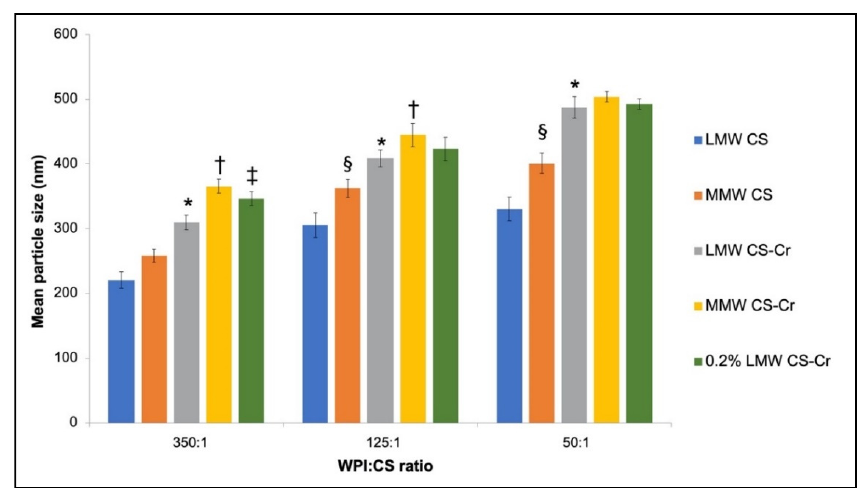
Figure 6. Particle size of chromium-entrapped WPI nanoparticles when using different MWs and concentrations of chitosan at various WPI:CS ratios. Results are shown as mean ± SD (n = 10). Data were considered statistically different when p < 0.05. * indicates a significant difference between LMW CS and LMW CS-Cr at the same ratio, † indicates a significant difference between LMW CS-Cr and MMW CS-Cr at the same ratio, ‡ indicates a significant difference between LMW CS-Cr and 0.2% LMW CS-Cr at the same ratio, § indicates a significant difference comparing 350:1 MMW CS to MMW CS at other ratios.